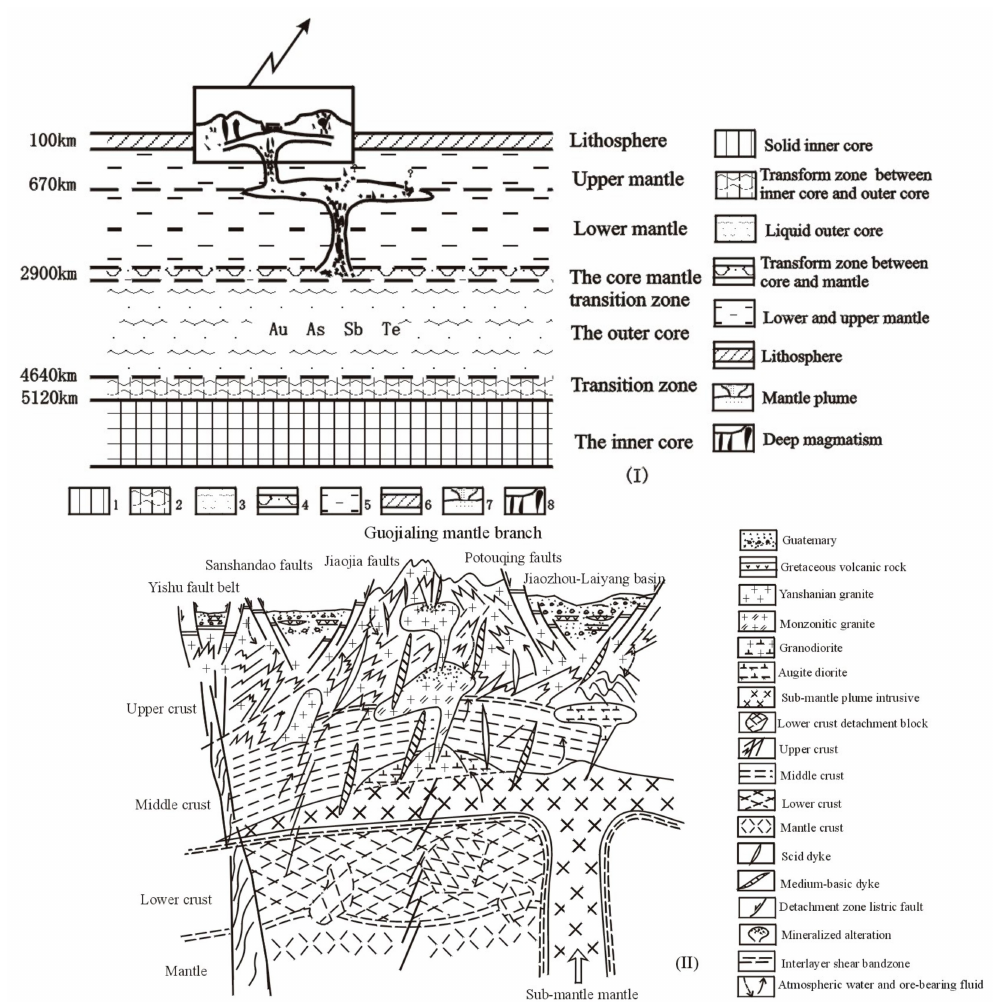
Figure 4. Sub-mantle plume-mantle branch evolution and its metallogenesis: Mantle plume-sub-mantle plume mode ( I ) and Sub-mantle plume-mantle branch metallogenic mode ( II